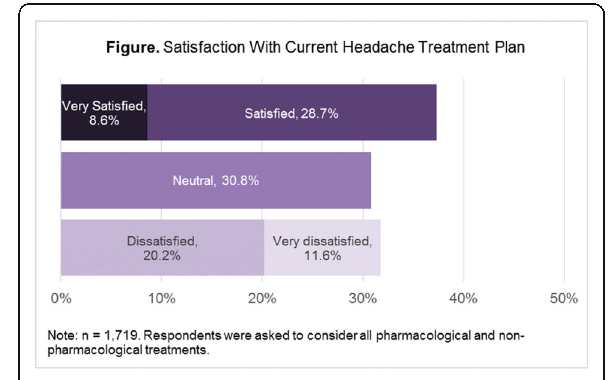
Fig. 1 (abstract P0219). See text for